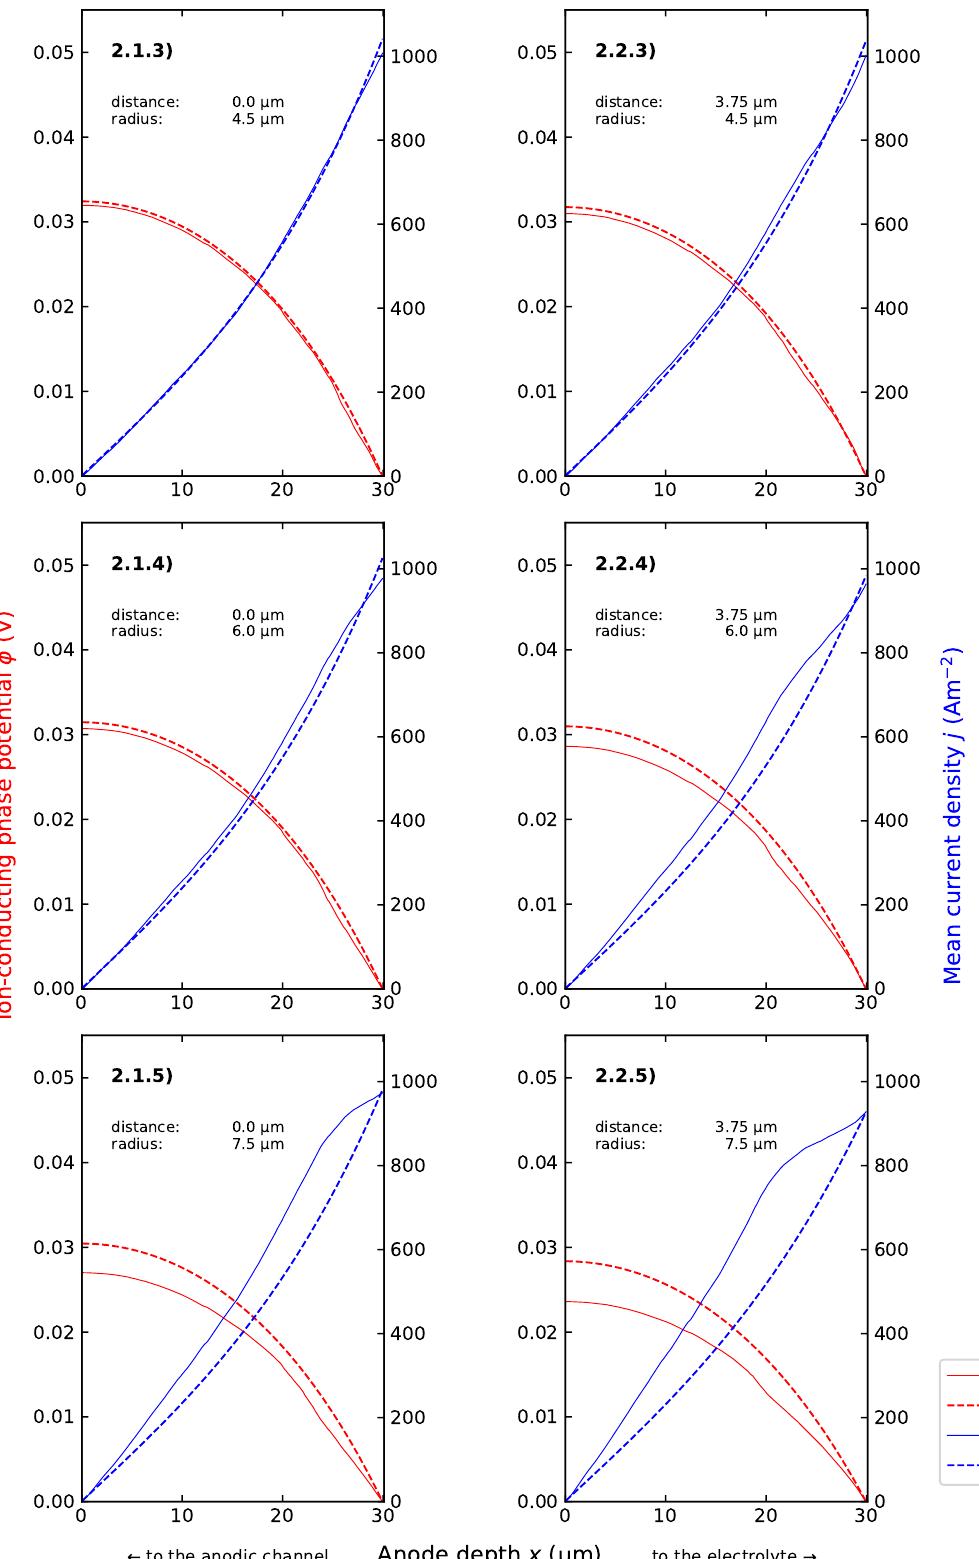
Figure 6. “Corner-type”, ion-conducting (YSZ) disturbance parametric study. Boundary conditions: = 3000 Pa. Thickness: 30.0µm. T = 1073 φ el,b = 0.05 V, p H = 97,000 Pa, p H 2 2 O